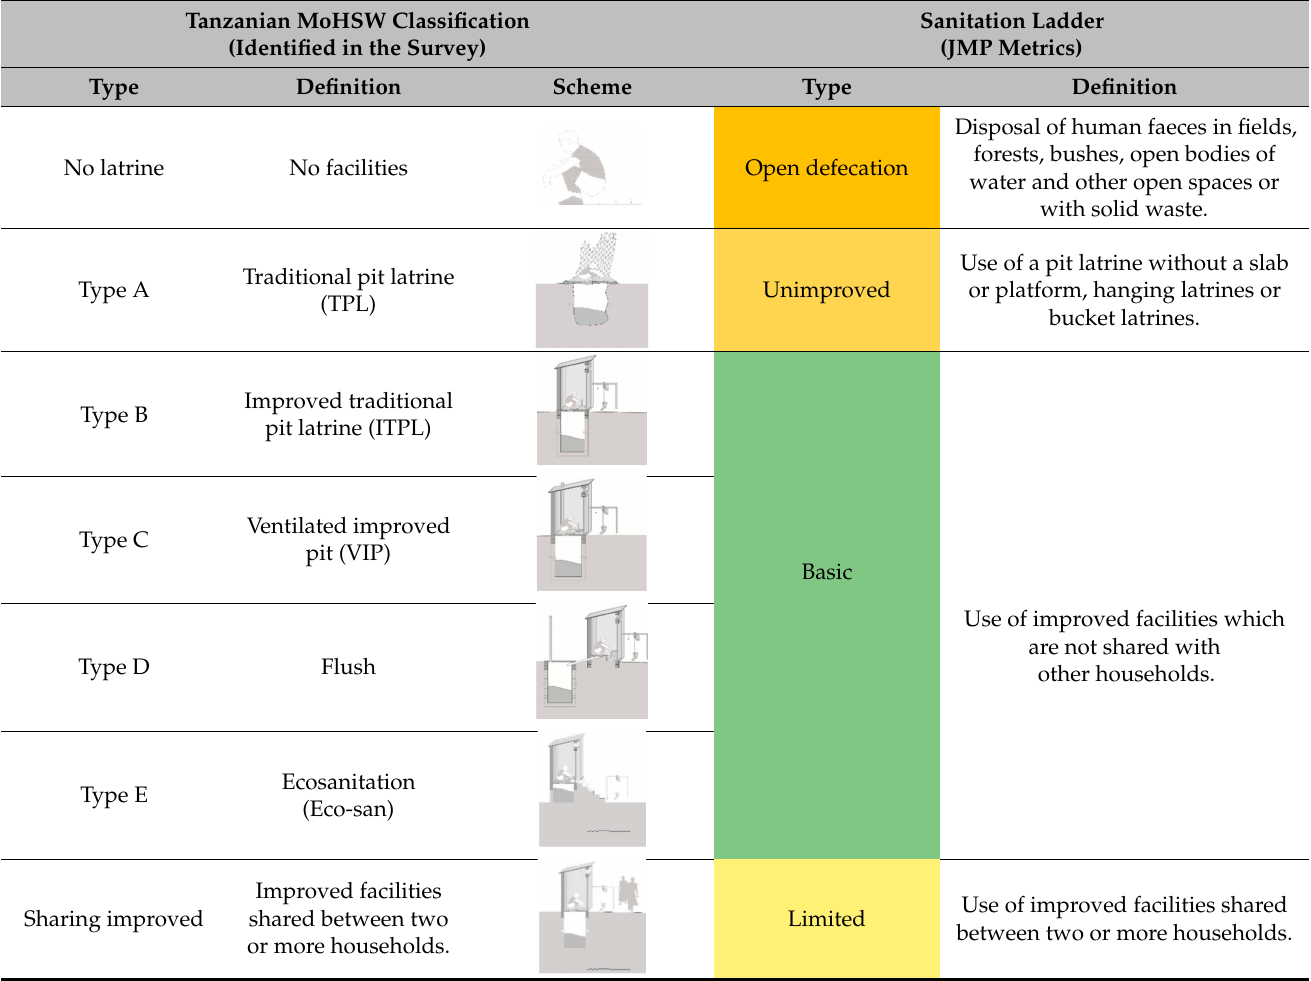
Table 1. Classification of each type of latrine and its level within the sanitation